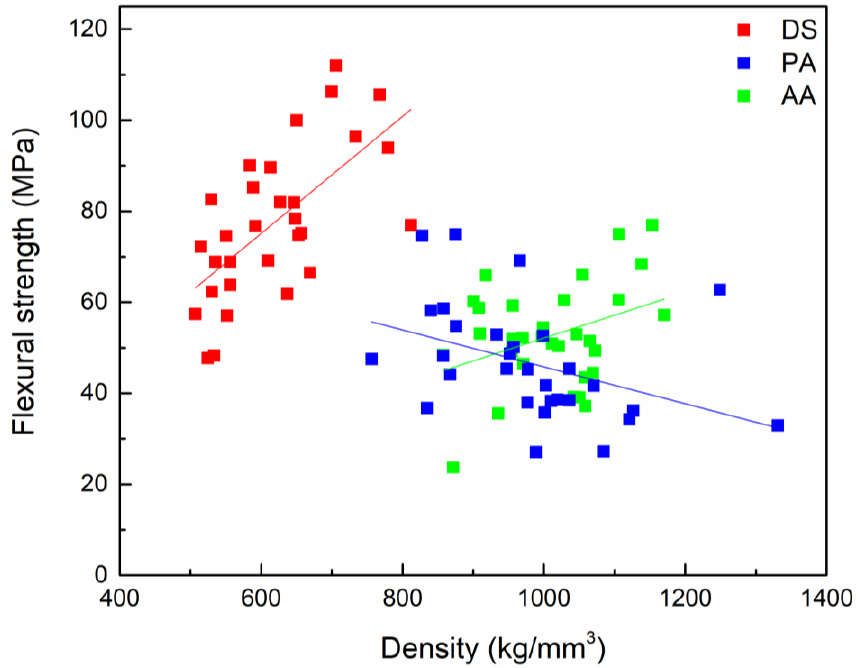
Figure 7. Graph showing relation of flexural fracture stresses with density after 6 months of aging. The lines in the graph represent the linear regression of the values obtained for each species.